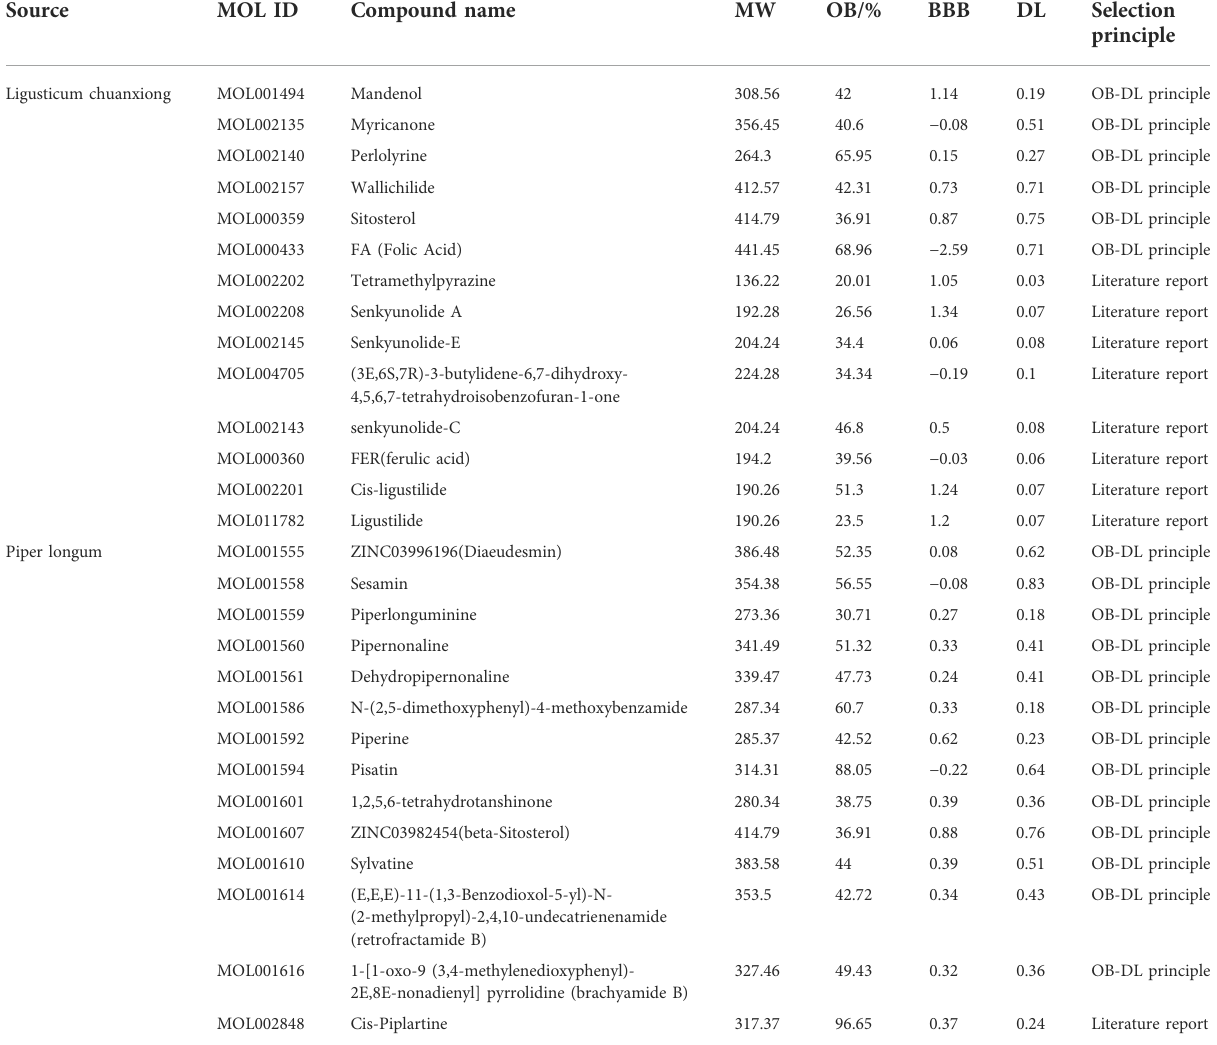
TABLE 1 Basic information of the active ingredients of Ligusticum chuanxiong-Piper longum couplet medicines. Source MOL